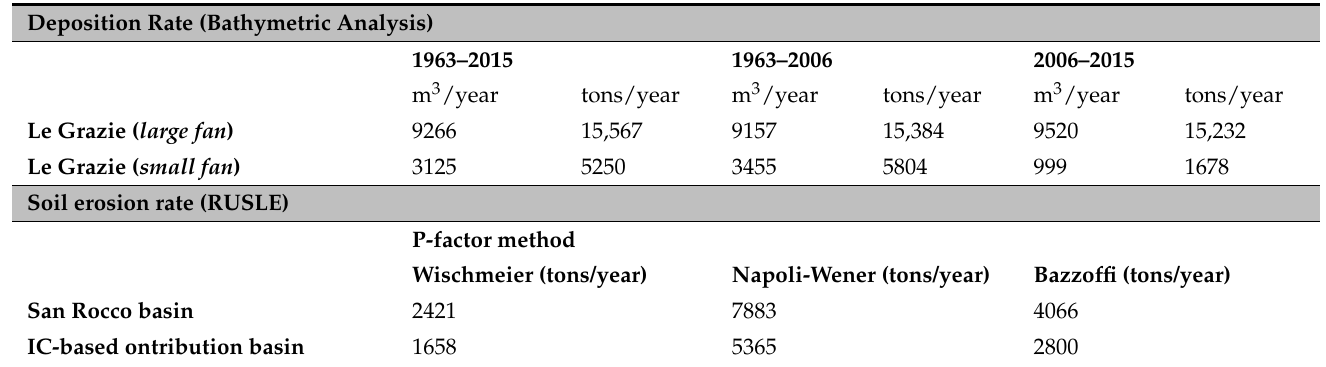
Table 5. Comparison between deposition rate calculated with direct measures and soil erosion rate evaluated by